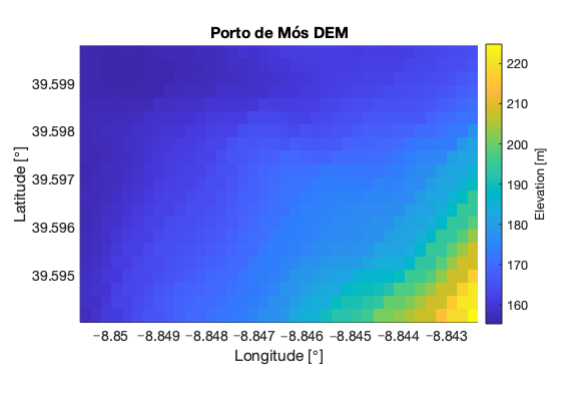
Figure 7. Satellite view of the testing area near Porto de Mós, Leiria .